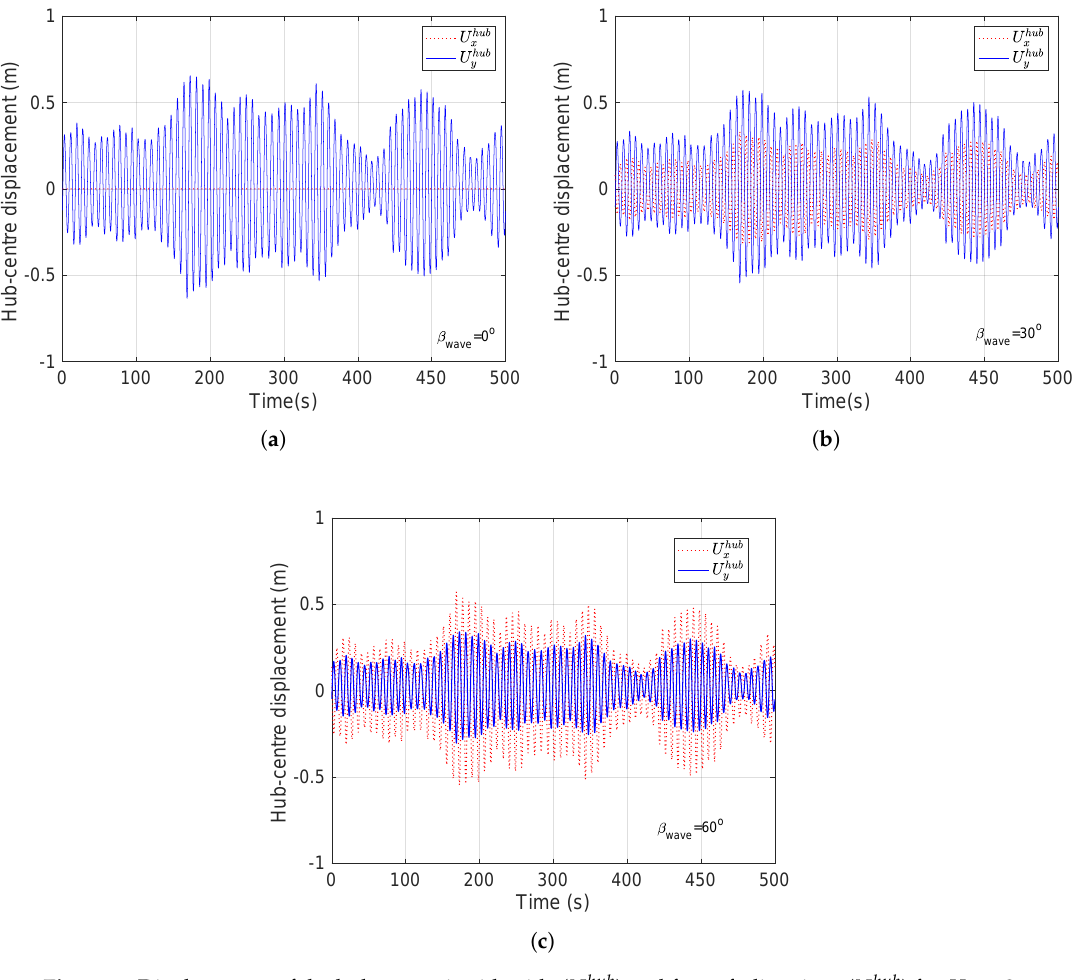
Figure 8. Displacement of the hub-center in side-side ( U hub x ) and fore-aft directions ( U hub y ) for H s = 2 m, U w = 8 m/s , T p = 4 s ( a ) β wave = 0° ( b ) β wave = 30° ( c ) β wave =